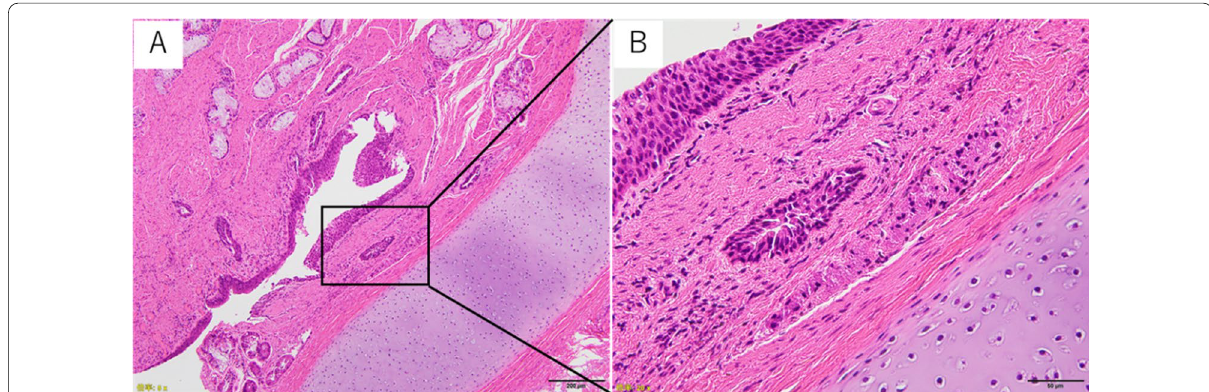
Fig. 5 Histological findings of the resected specimen showing the tracheal cartilage and the stratified squamous epithelium which originated from the esophagus. ( A H&E 100, B H&E × ×